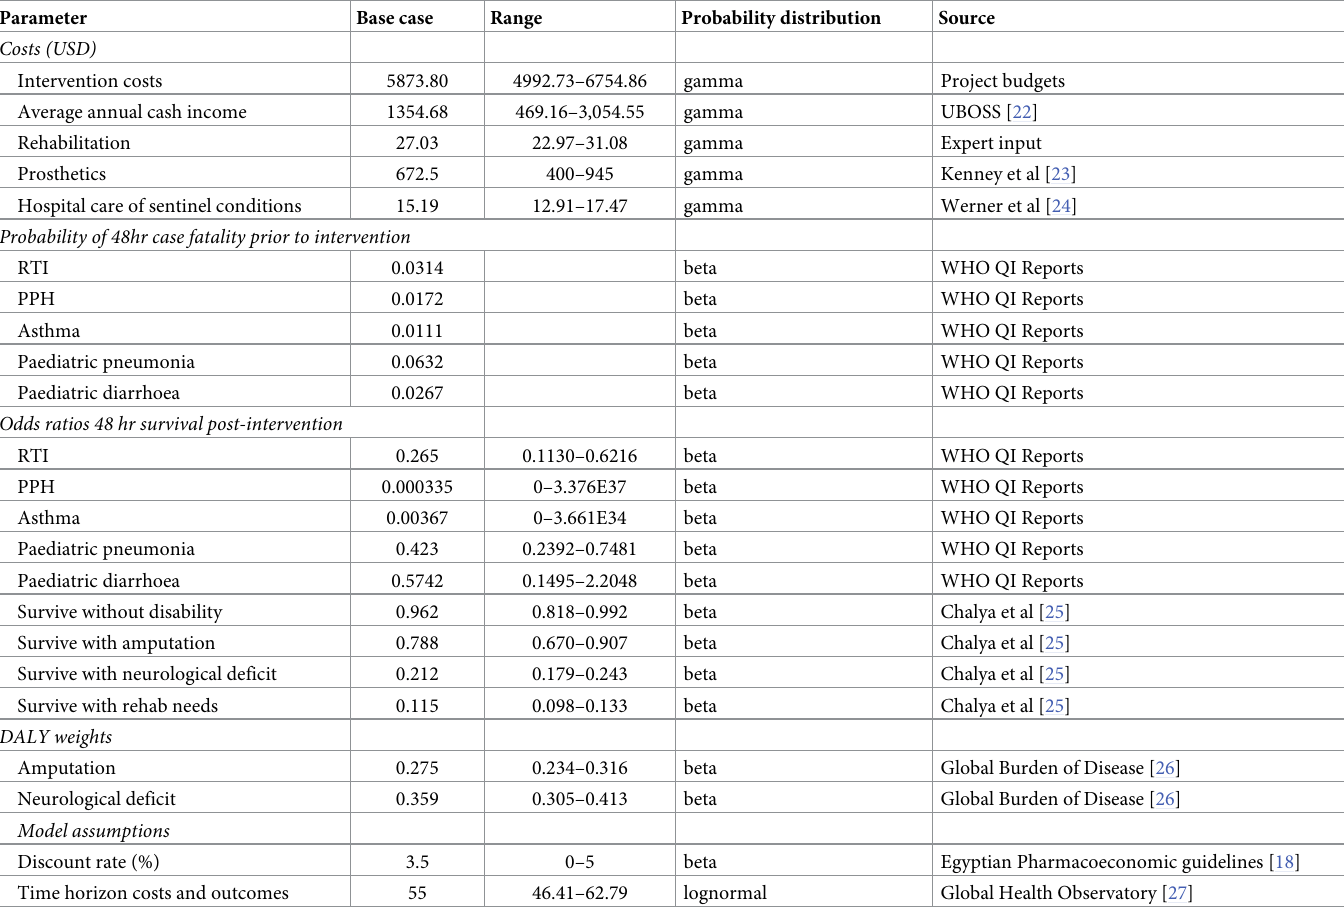
Table 1. Model parameter range and probability